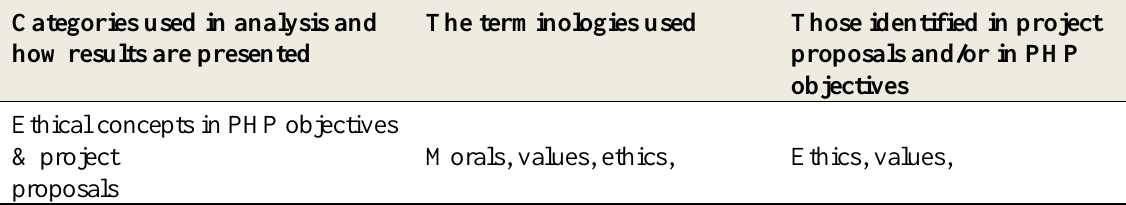
Table 2. Presentation of the